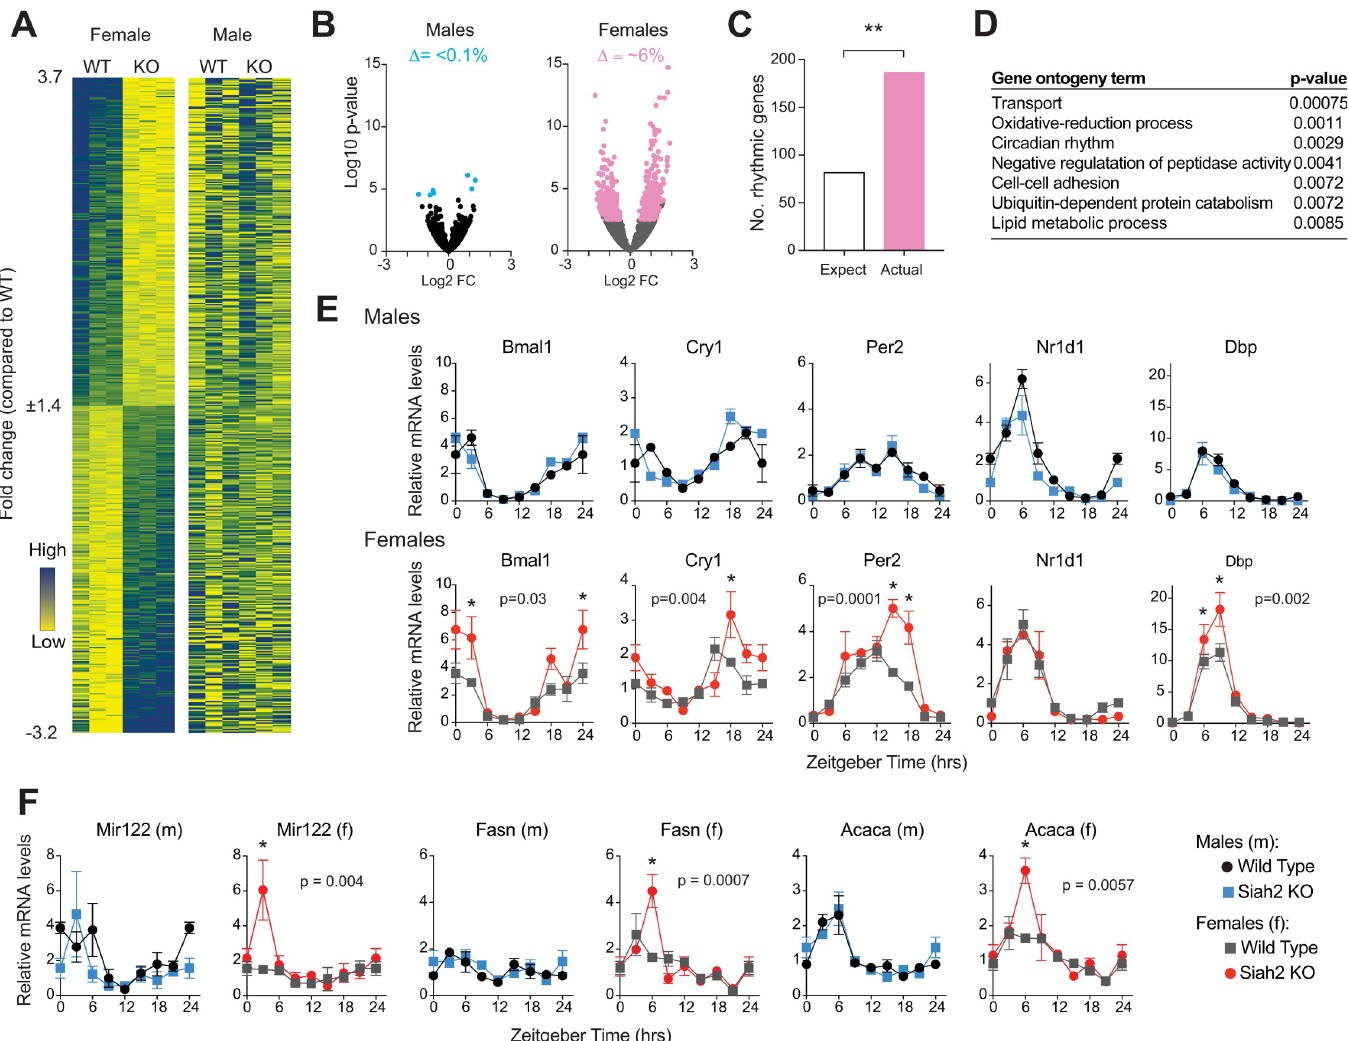
Fig 1. SIAH2 loss preferentially alters daily gene expression in females. A . Heatmaps depicting the expression of the genes affected by SIAH2 loss in female livers harvested at ZT10 in all four groups. FDR corrected p-value < 0.05 was used as a cutoff. Each gene is aligned across genotype (WT = wild type, KO = Siah2 -/- ) and sex. B . Volcano plots comparing hepatic gene expression changes within sex (n = 3/group). Colored transcripts are significantly changed by SIAH2 loss in male (blue) or females (pink) as determined by DESeq2 (adj p < 0.05). C . Enrichment of rhythmically expressed genes among those altered by SIAH2 loss in females, using 16% as the expectation for rhythmic genes (http://circadb.hogeneschlab.org/mouse, Ref 19; � = p < 0.0001 Fisher’s exact test). D . DAVID gene ontogeny of the rhythmic genes altered by SIAH2 loss in females. Also see S1 Dataset. E-F Quantitative RT-PCR profiles of clock and REVERB α target gene mRNAs in liver (mean +/- sem, n = 3 livers per genotype, sex and time.). The Zeitgeber time (ZT) 0 point is double plotted at ZT24 for clarity. ZT0-12 = lights on, ZT 12–24 = lights off. P-values shown reflect significant time x genotype interactions (two-way ANOVA). � = p < 0.05 between genotypes at individual timepoints (Sidak’s multiple comparison